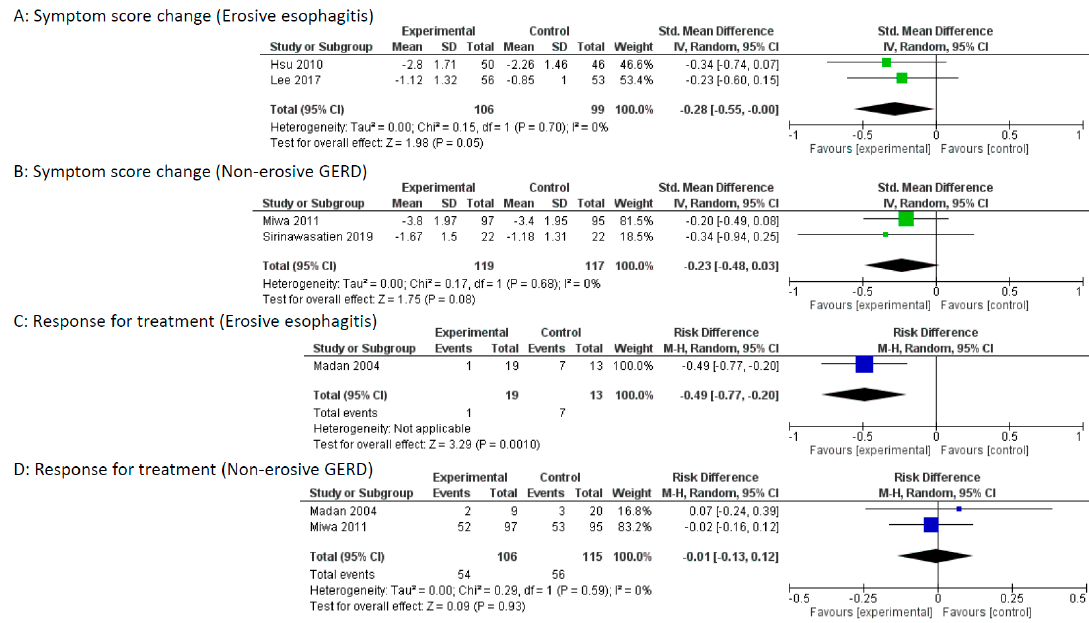
Figure 5. Subgroup analysis between non-erosive gastroesophageal reflux disease (GERD) and erosive esophagitis. ( A ) Forest plot of the standardized mean difference (SMD) with 95% confidence intervals (CI) of symptom score change for mosapride combined with PPI versus PPI alone for erosive esophagitis. ( B ): Forest plot of the SMD with 95% CI of symptom score change for mosapride combined with PPI versus PPI alone for non-erosive GERD. ( C ): Forest plot of the risk difference (RD) with 95% CI of response rate for mosapride combined with PPI versus PPI alone for erosive esophagitis. Events represent treatment failure. ( D ): Forest plot of the RD with 95% CI of response rate for mosapride combined with PPI versus PPI alone for non-erosive GERD. Events represent treatment failure.